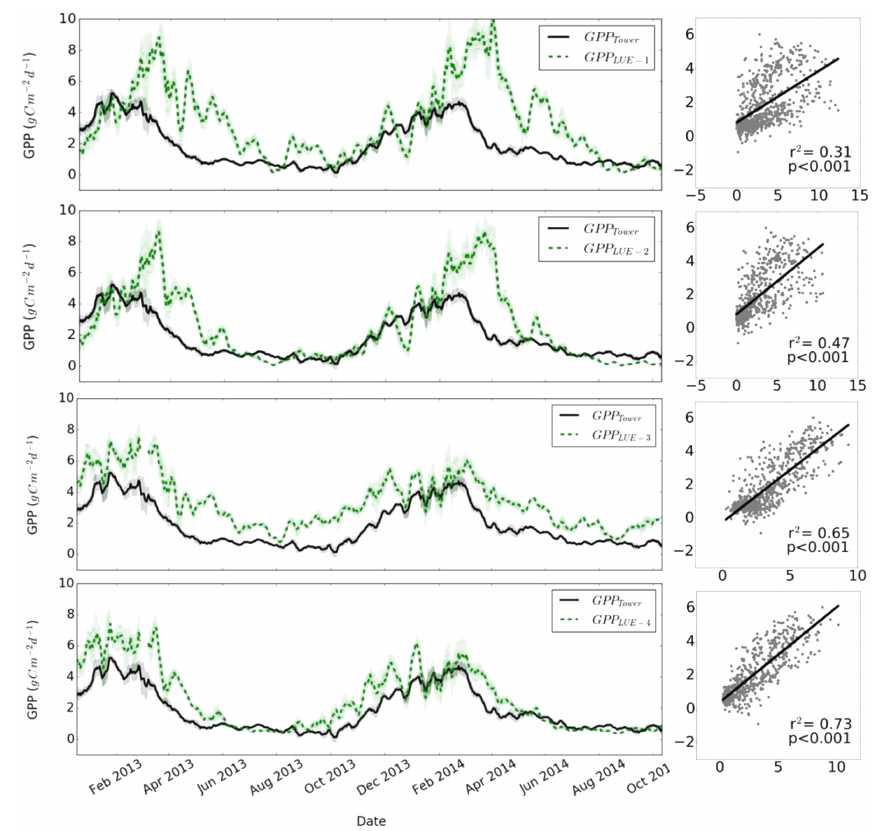
Figure 9. Understory flux tower estimated GPP with model predicted GPP for the Howard Springs OzFlux site. Models shown are (a) light use efficiency (LUE-1), (b) LUE with evaporative fraction (LUE-2), (c) LUE with green chromatic coordinates (LUE-3) and (d) LUE with EF and GCC